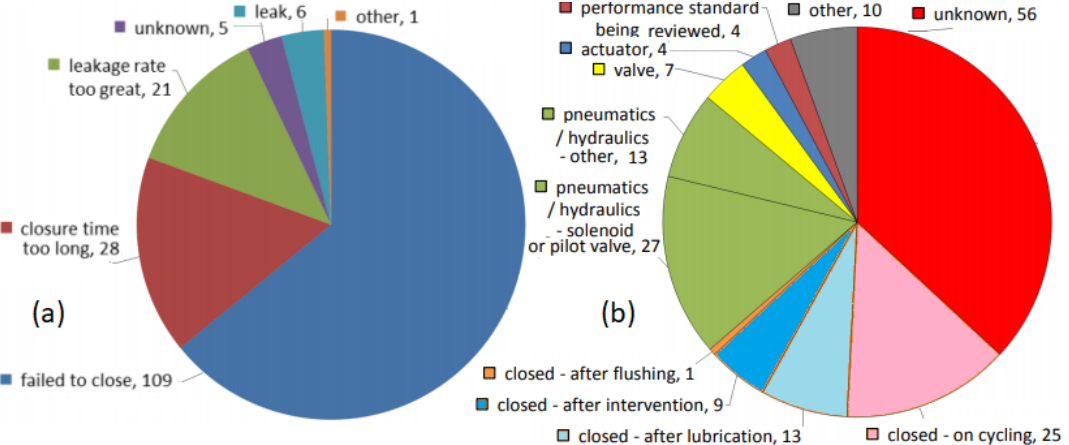
Figure 4. Incidents from riser emergency shutdown valve failures in HSE 2015 report, for ( a ) underlying causes and ( b ) immediate causes (Source: HSE UK, in public domain).